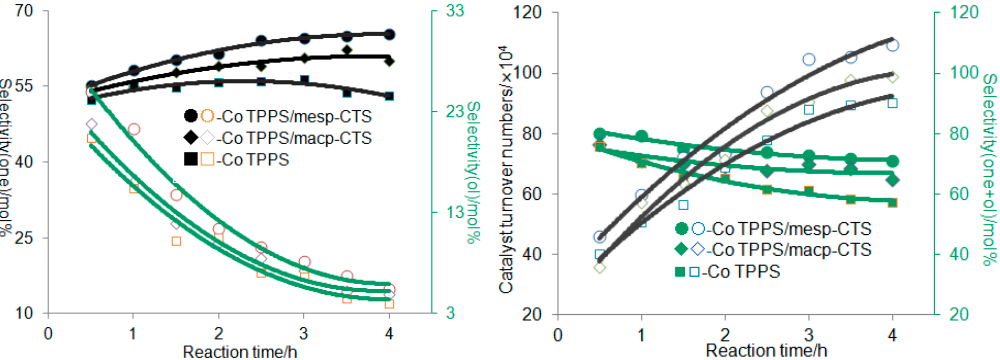
Figure 7. Comparison of the selectivity (one + ol) and TON of three catalysts.